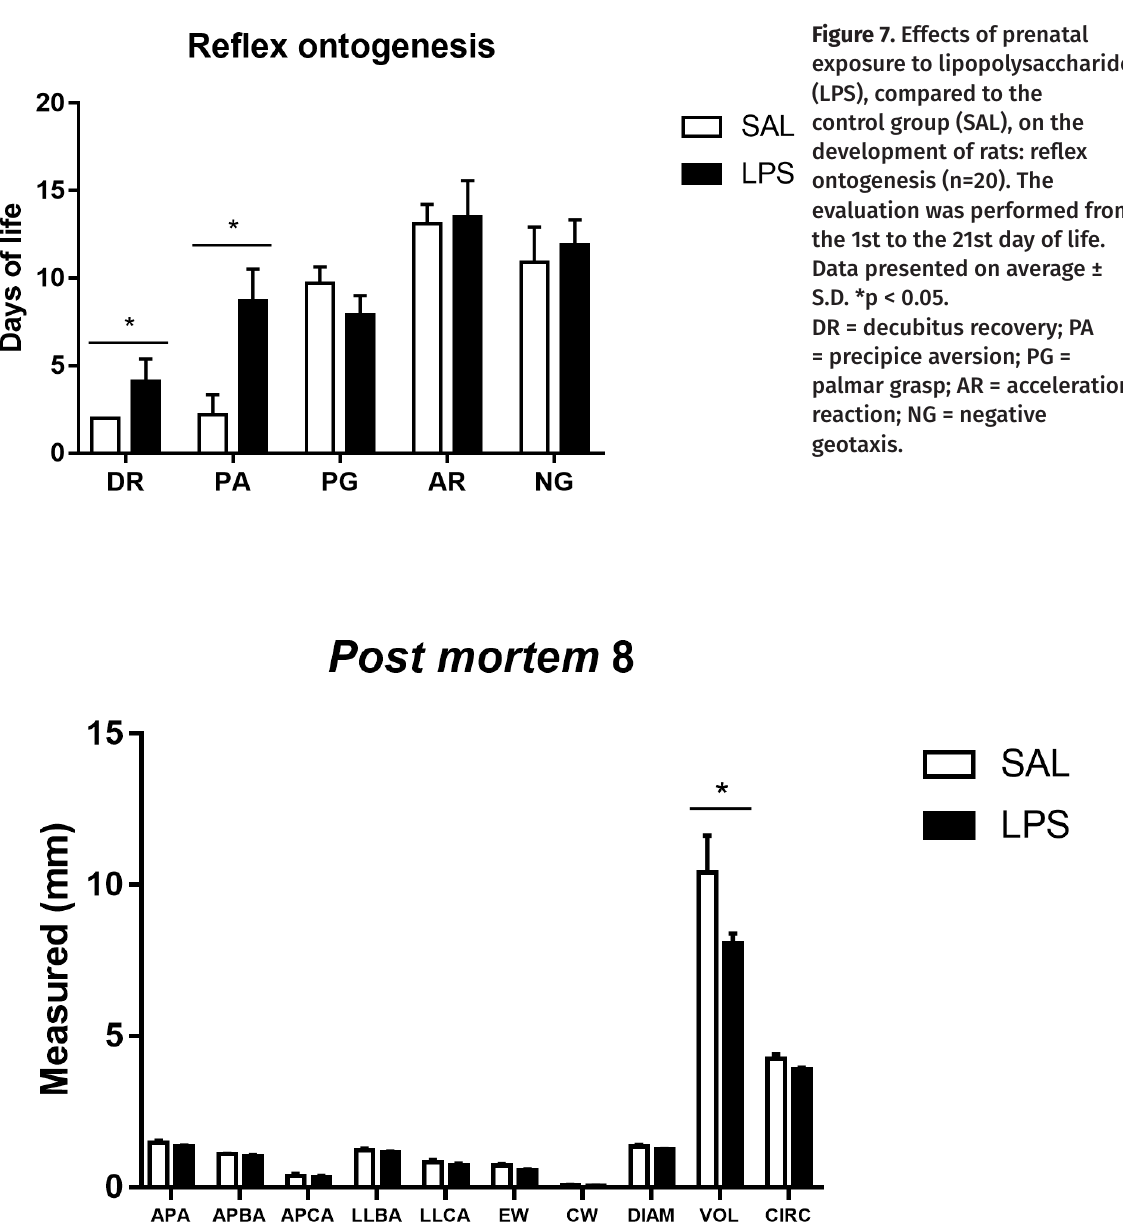
Figure 8. Effects of prenatal exposure to lipopolysaccharide (LPS), compared to the control group (SAL), on the development of rats: post mortem brain (n=17). The evaluation was performed on the 8th postnatal day. Data presented on average ± S.D. *p < 0.05. APEA = anterior-posterior encephalium axis; APBA = anterior-posterior brain axis; APCA = anterior-posterior cerebellum axis; LLBA = laterolateral axis of the brain; LLCA = laterolateral axis of the cerebellum; EW = encephalic weight; CW = cerebellum weight; DIAM = diameter; VOL = volume; CIRC =